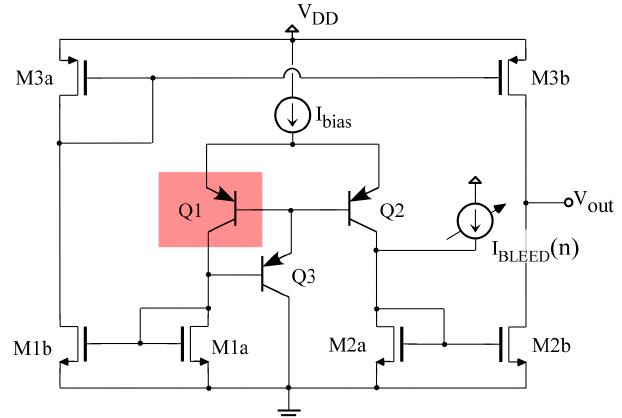
Figure 6. Schematic of the temperature sensor with current bleeding for extended dynamic range and variability compensation.